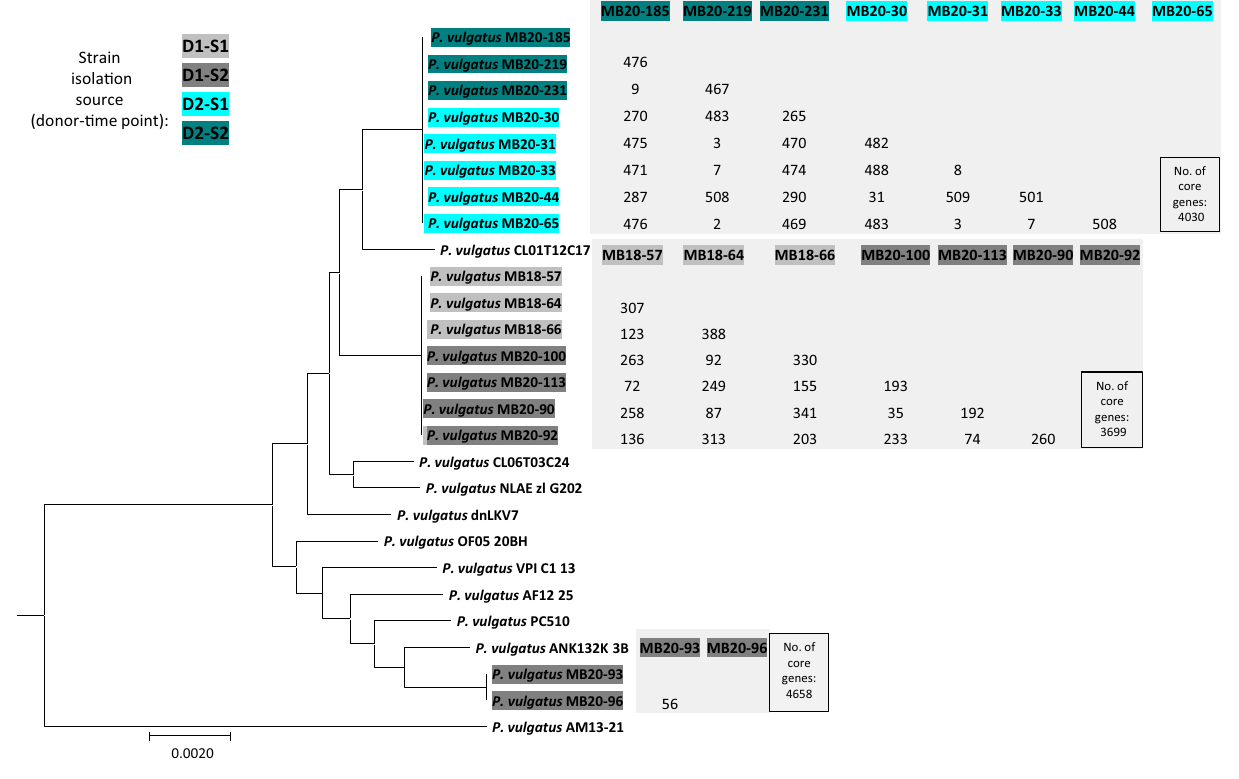
Figure 2. Phylogenetic tree based on core-genome alignment of P. vulgatus strains and genomic differences between strains clustered in one developmental line. Strains isolated from donors 1 and 2 are highlighted in grey and blue, respectively. Pairwise distances of the core genomes of bacterial strains in one developmental line is expressed as single nucleotide polymorphisms (SNPs) and shown in the corresponding matrix. Phylogenetic trees of B. uniformis, B. ovatus and B. thetaiotaomicron strains are presented in Supplementary Fig.